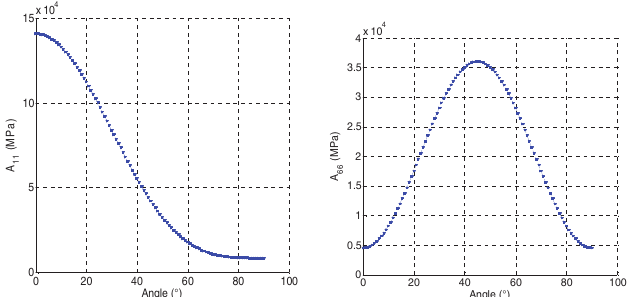
Fig. 4. A11 and A66 in function of the orientation angle.